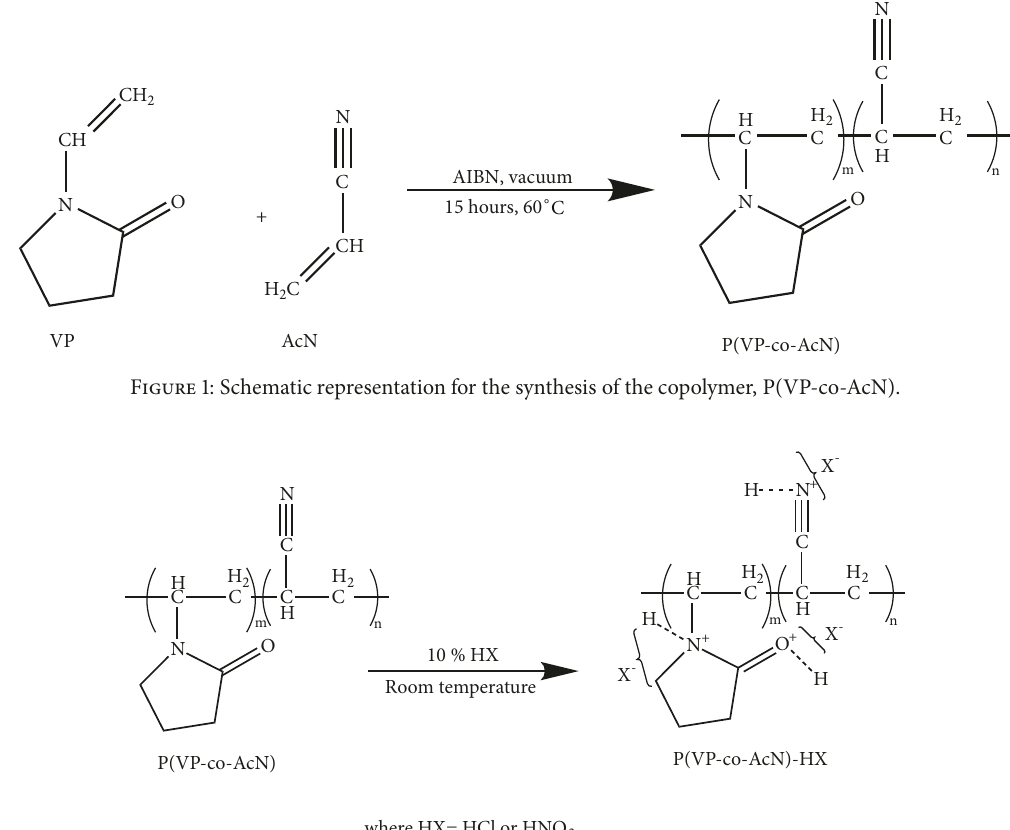
cells SS | P(VP-co-AcN) | SS, SS | P(VP-co-AcN)-HCl | SS,